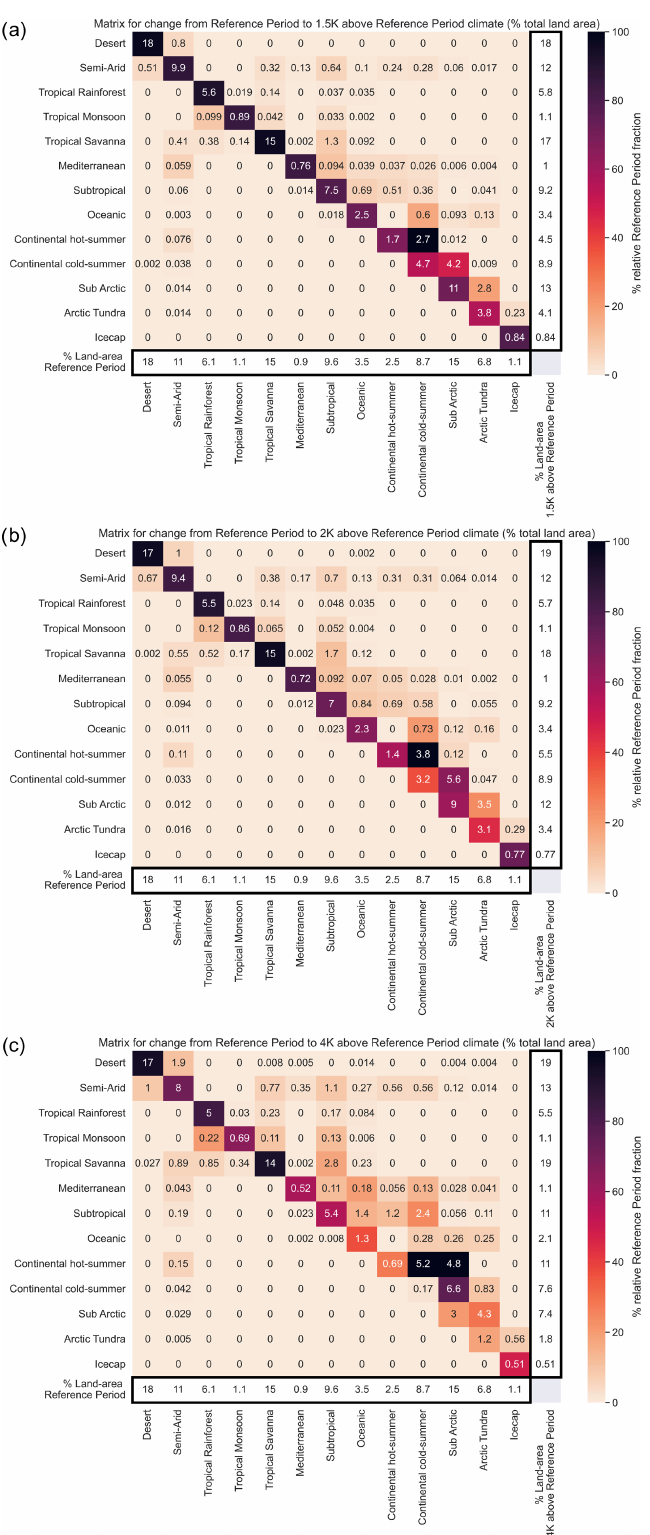
Figure 5. Multi-model ensemble mean difference matrices highlighting the classification changes for levels of warming above the reference period of (a) 1.5K, (b) 2K, and (c) 4K using the streamlined classification